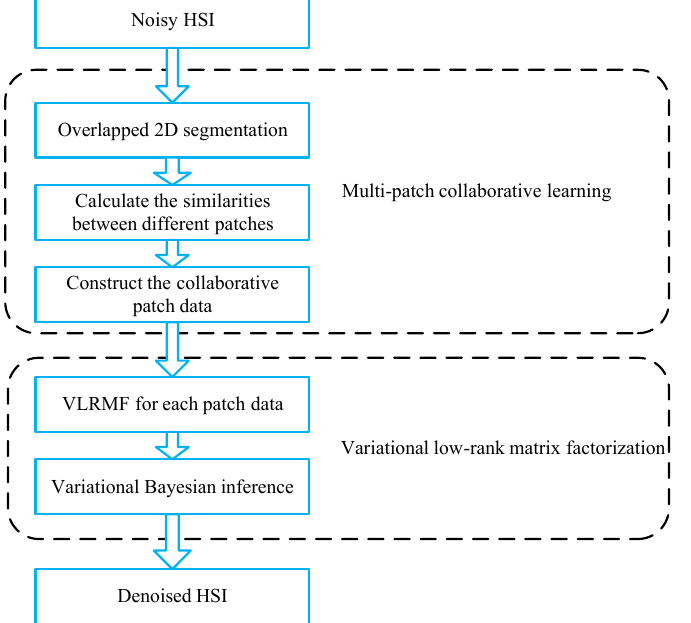
Figure 1. The framework of the proposed variational low-rank matrix factorization with multi-patch collaborative learning (VLRMFmcl) method. HSI, hyperspectral image.